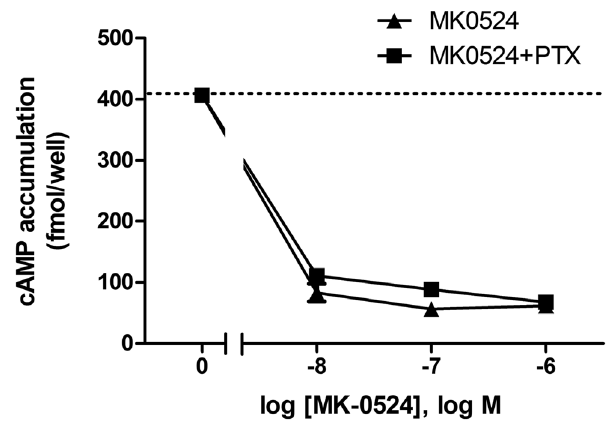
Figure 2. The MK-0524-mediated reduction in DP1 cAMP signaling below basal levels is unaffected by pertussis toxin. HEK293 cells transiently expressing Flag-DP1 pretreated or not with 1 m g/ml of pertussis toxin (PTX) for 10 min were incubated with increasing concentrations of MK-0524 and cAMP levels were measured as described in ‘‘Materials and Methods’’. Results are presented as fmol of cAMP generated per well. Data are the mean 6 S.E. of at least three independent